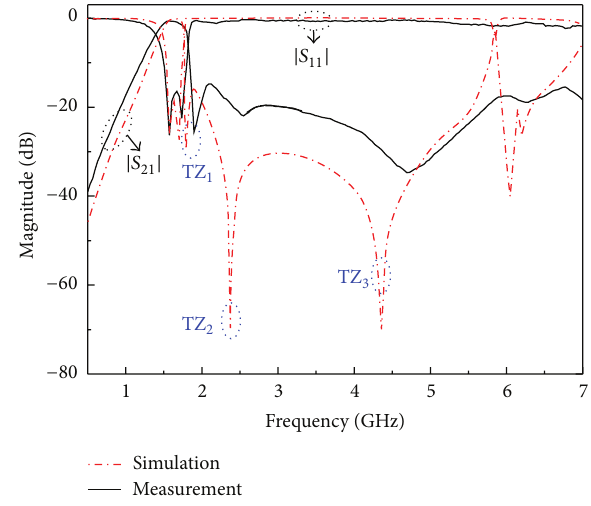
Figure 6: Measured and simulated response of the proposed